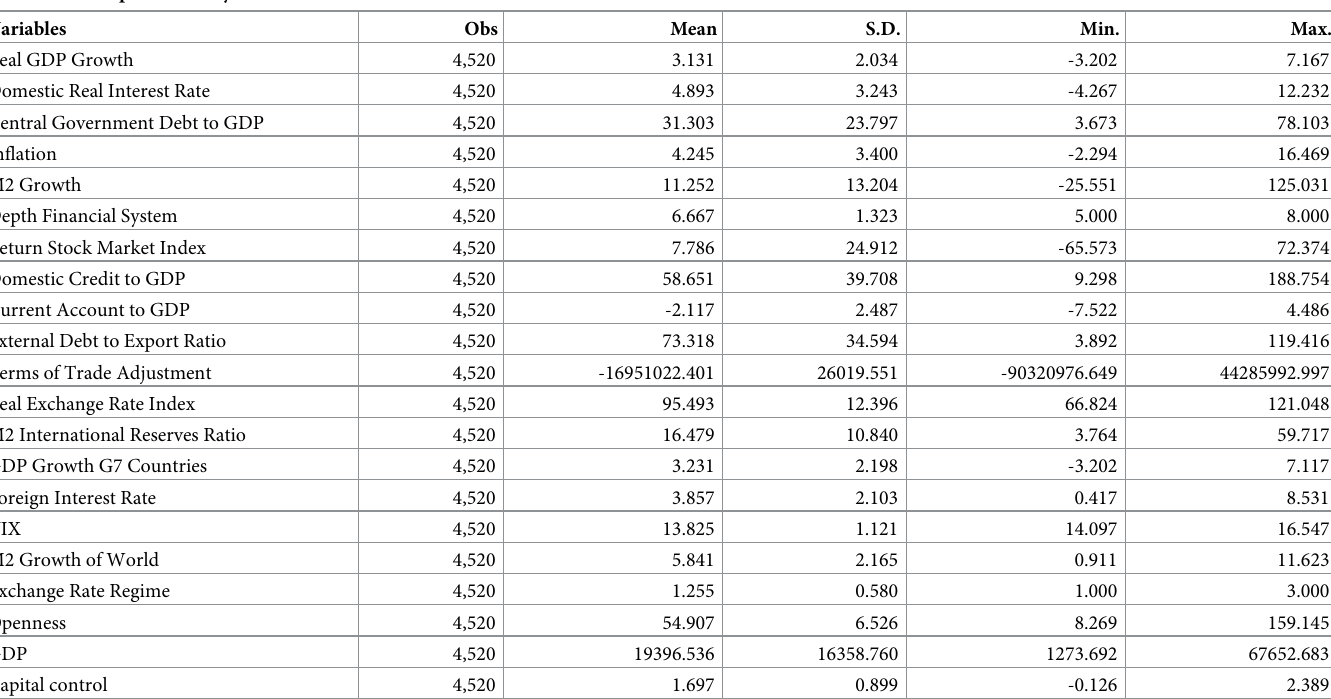
Table 3. Developed summary statistics.